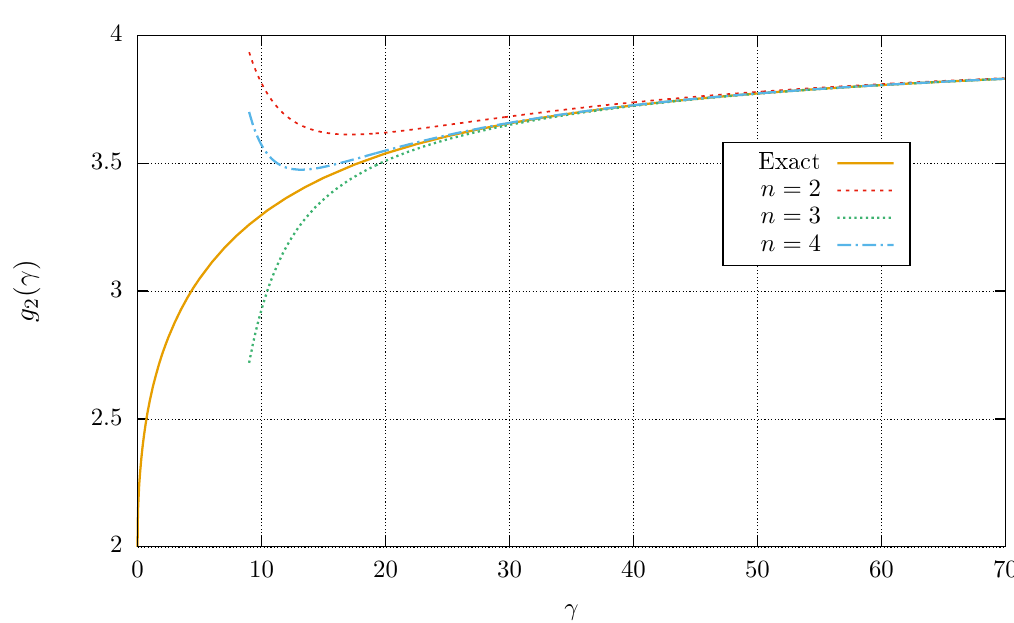
( γ ) in the stationary state at late times after the Figure 2: Local pair correlation function g 2 quench. The numerical solution of Eqns (83), (84) is shown as a solid orange line. The asymptotic expansion (88) around γ = ∞ up to order (cid:79) ( γ − n ) with n = 2,3,4 is seen to be in good agreement for large values of γ